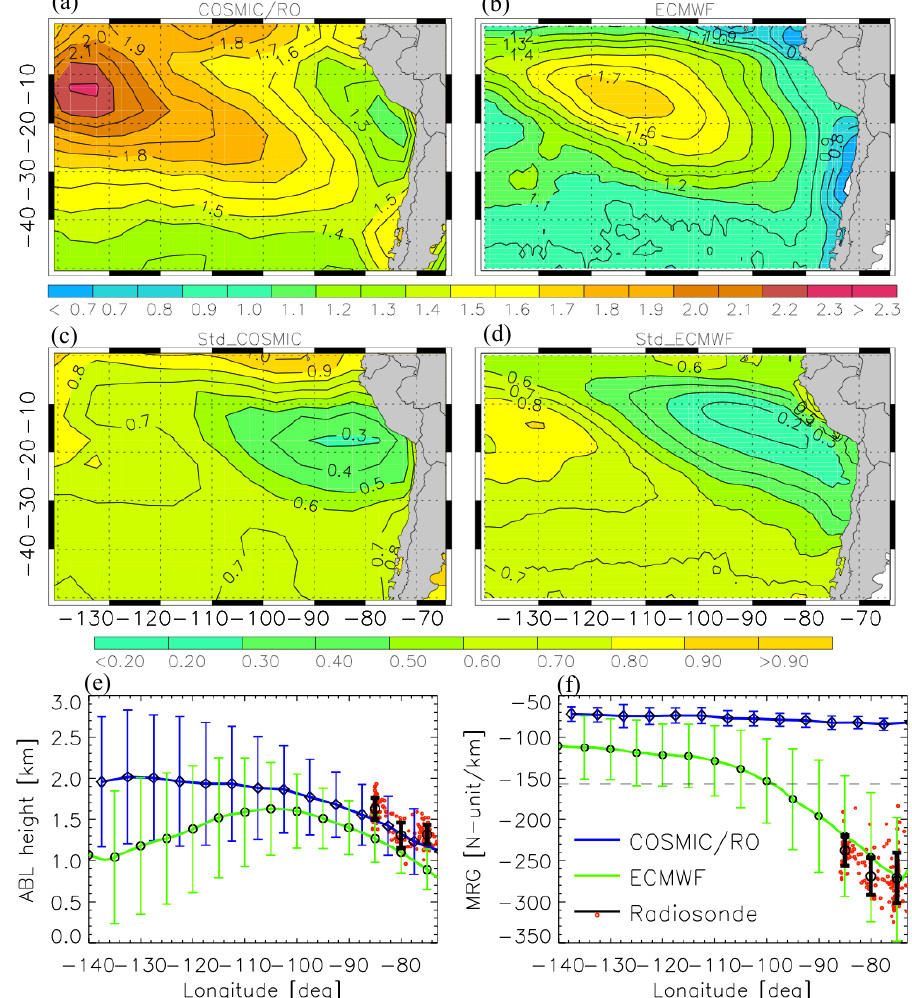
Fig. 7. Mean ABL height climatology (September–November in 2007, 2008 and 2009) for (a) COSMIC RO and (b) ECMWF analysis. The standard deviation of the ABL heights is shown in (c) and (d) , respectively. The ABL heights and the MRG (mean and standard deviation) along the transects at: ∼ 22.5 ◦ S (COSMIC), 22 ◦ S (ECMWF) and ∼ 20 ◦ S (radiosonde) are illustrated in (e) and (f) respectively. The horizontal black dashed line in (f) denotes the critical refraction gradient.